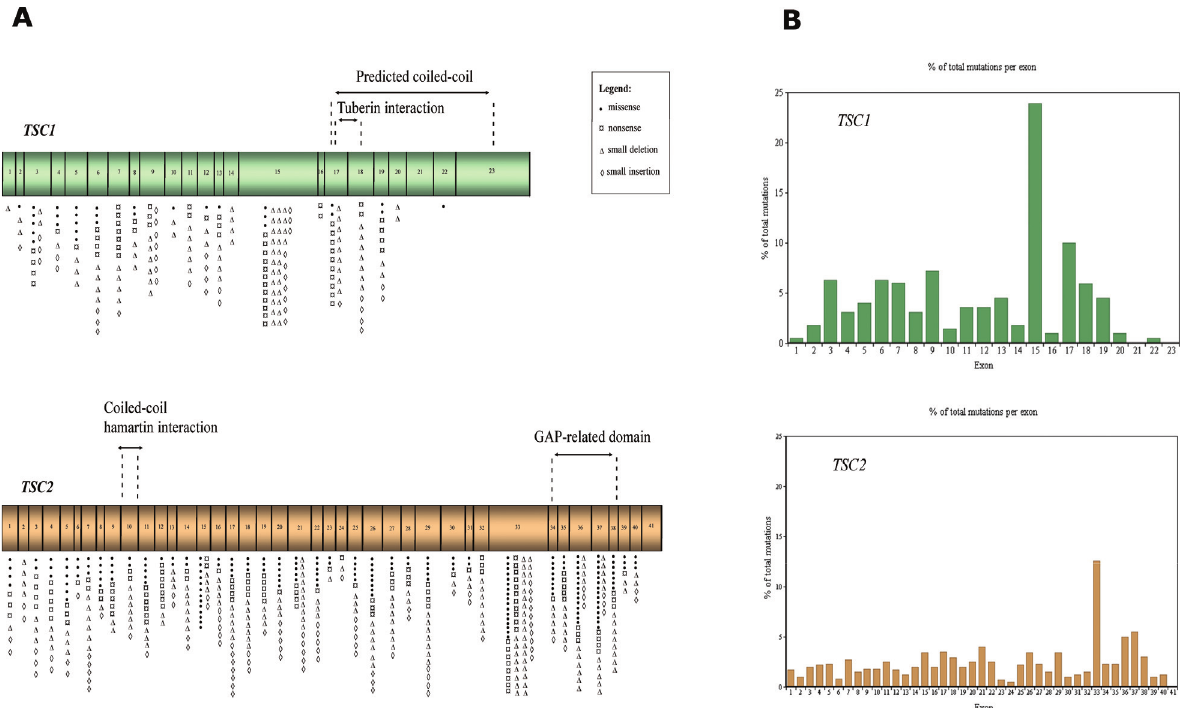
Figure 1 - TSC1 and T SC2 gene structure, domains and distribution of point mutations. (A) Schematic representation of TSC1 and TSC2 exons and the domains of hamartin and tuberin, respectively, codified by them. The symbols represent the number of different mutations described at each exon. (B) The graph shows the percentage of the total number of described mutations that occur at each TSC1 and TSC2 exon.